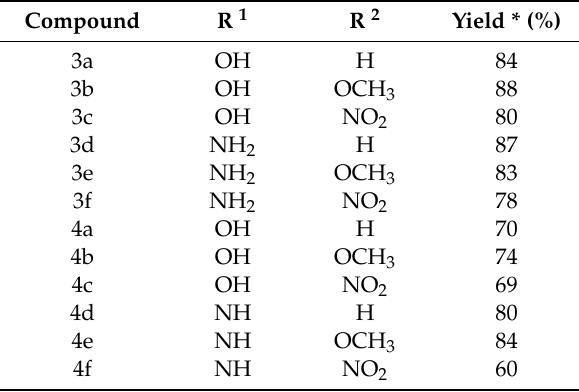
Table 1. Expected yields under optimal conditions.